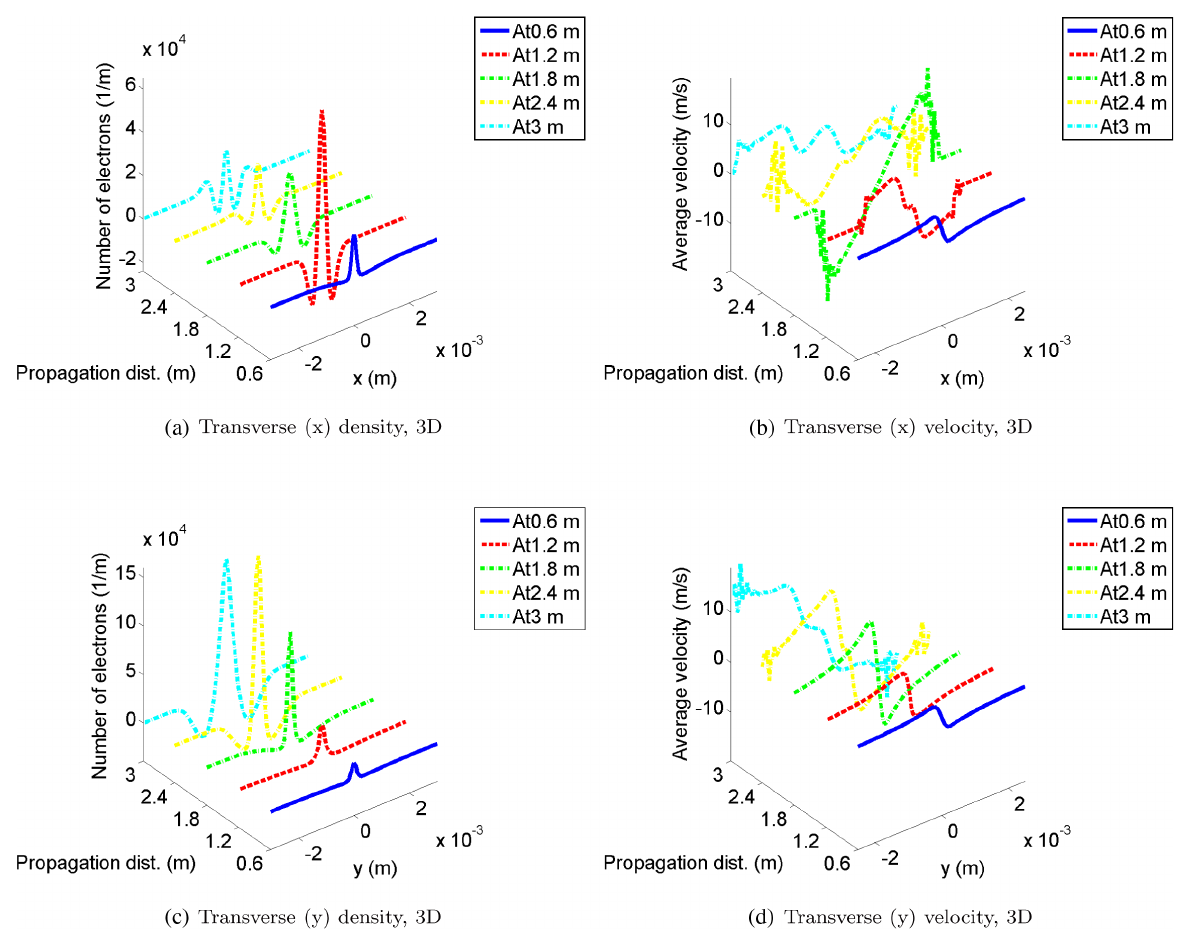
FIG. 13. Transverse density and velocity modulation by stationary ion on axis of the Gaussian electron beam in the CeC modulator: blue, solid line — after 0.6 m, red, dash line — after 1.2 m, green, dash-dot line — after 1.8 m, yellow, dash-dot line — after 2.4 m, and cyan, dash-dot line — after 3m of copropagation through the